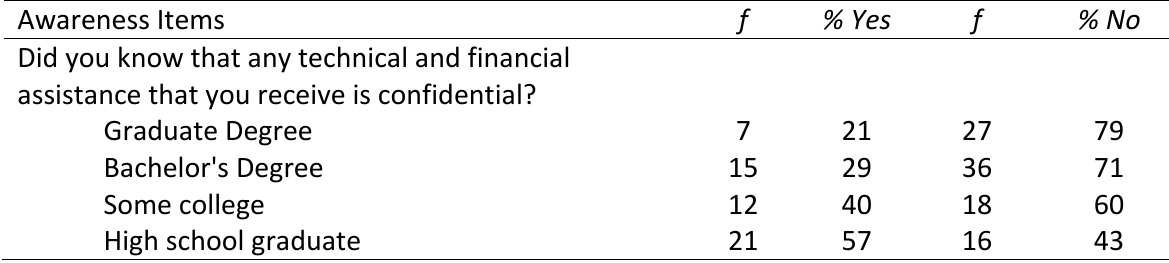
Descriptive Statistics of Education on Awareness of Natural Resources Conservation Service & Texas State Soil and Water Conservation